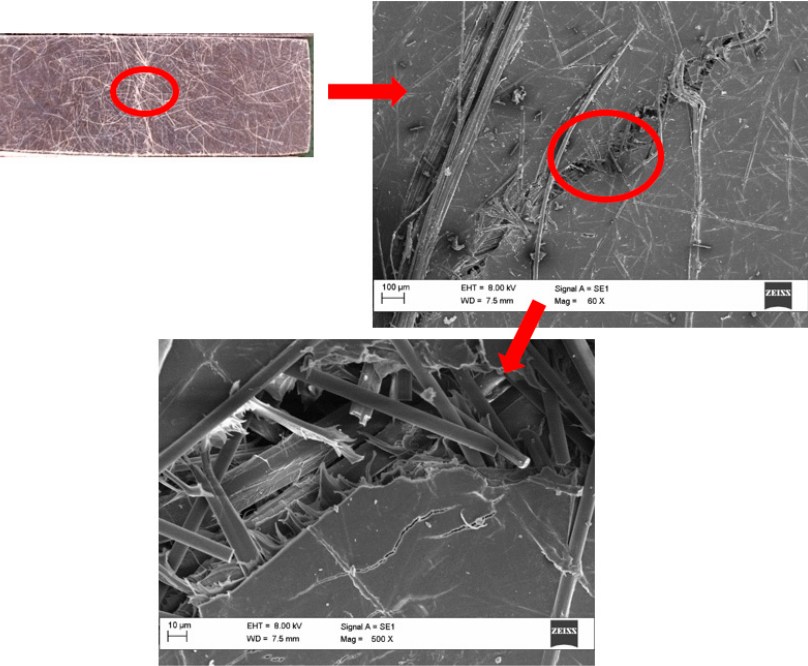
Figure 10. SEM images of the matrix crack of specimen 4-3 in 60× and 500× magnification.